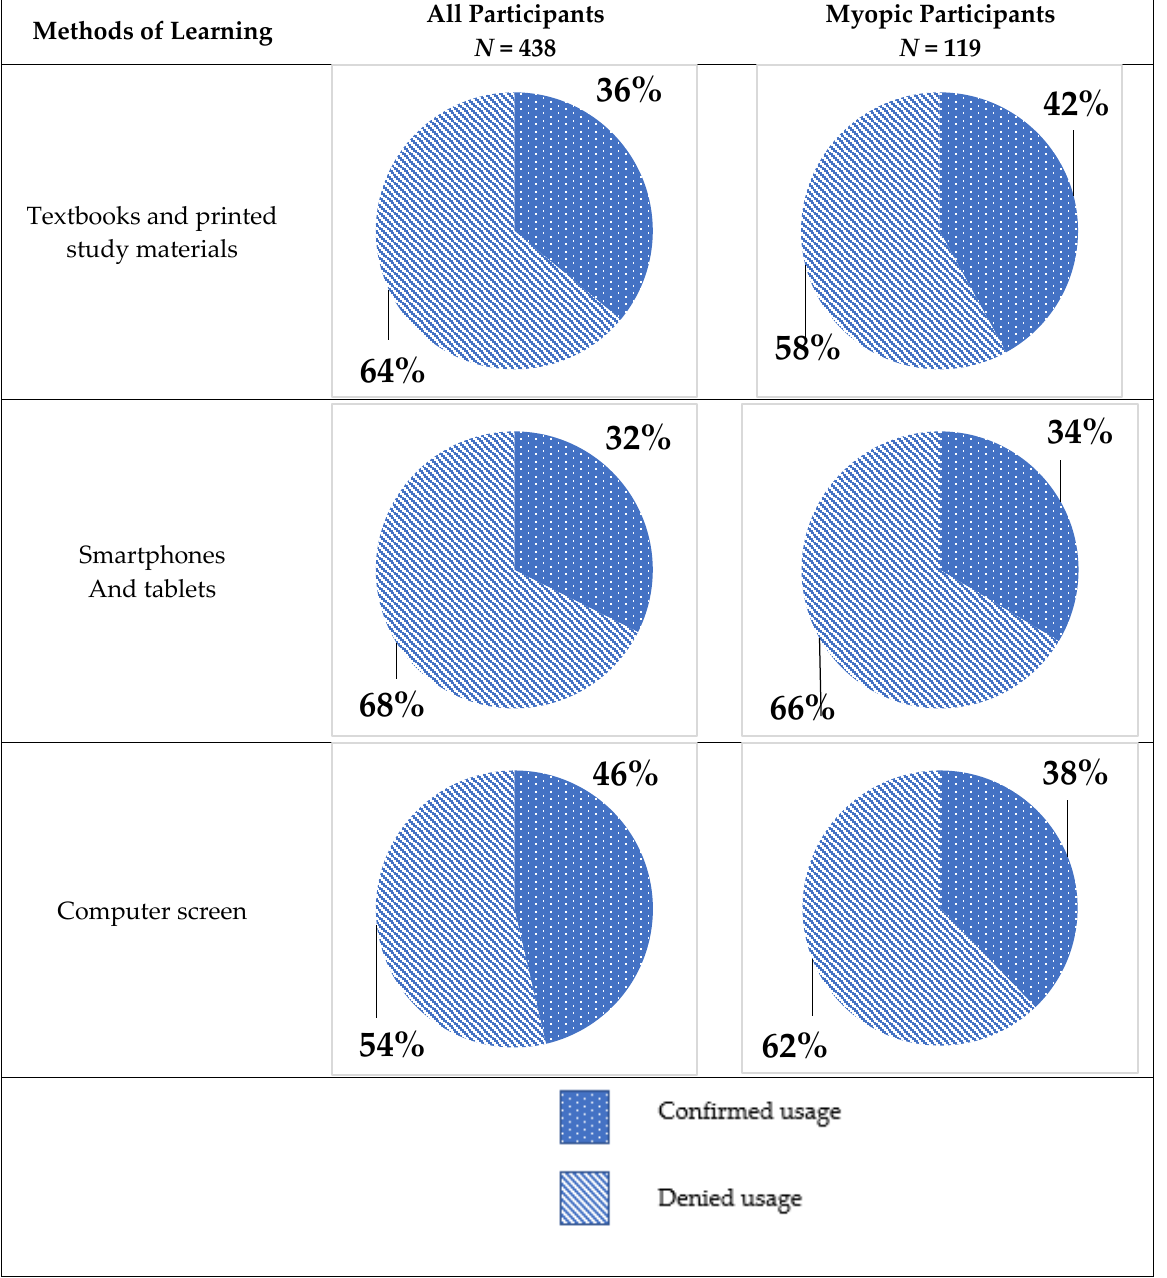
Figure 1. Usage of technical devices and printed study materials in the whole study population and myopic